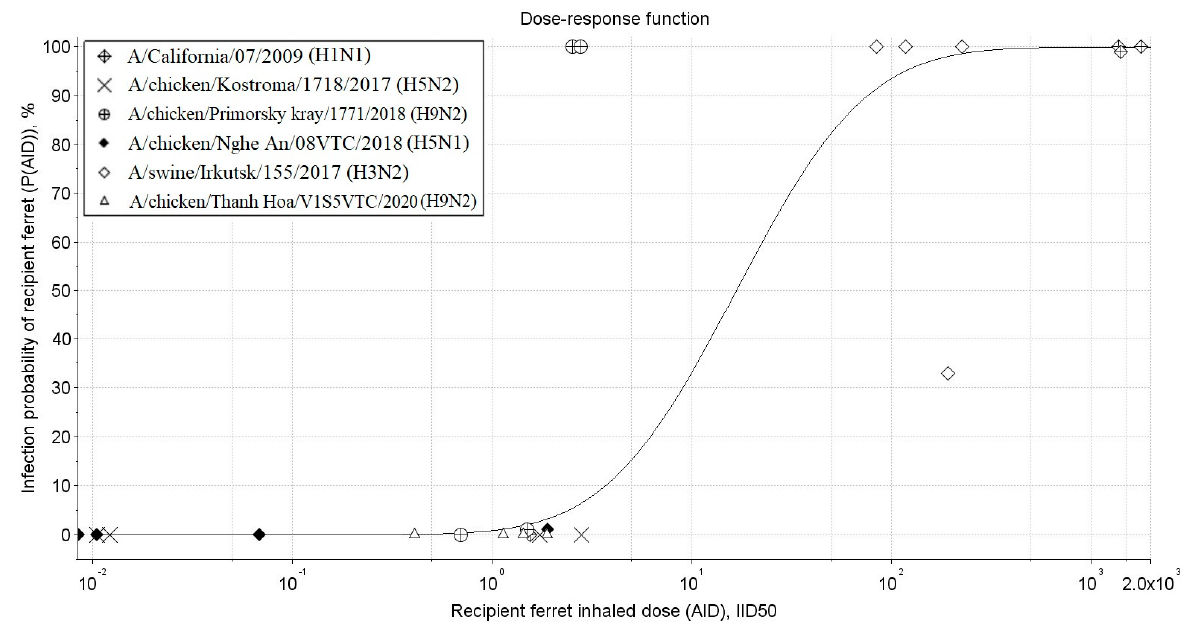
Figure 4. Effect of AID received from the air contaminated by donor ferrets on the probability of infection P(AID) in recipient ferrets. The X axis—AID inhaled by recipient ferrets expressed in IID 50 units. The Y axis—proportion of infected recipient ferrets expressed as %. Experimental points for different influenza virus strains were approximated using a sigmoid function with the following parameters: AID 50 = 16.75 IID 50 and σ = 1.18. Curve parameters were calculated based on the experimental points using Origin 8.1 data analysis package.